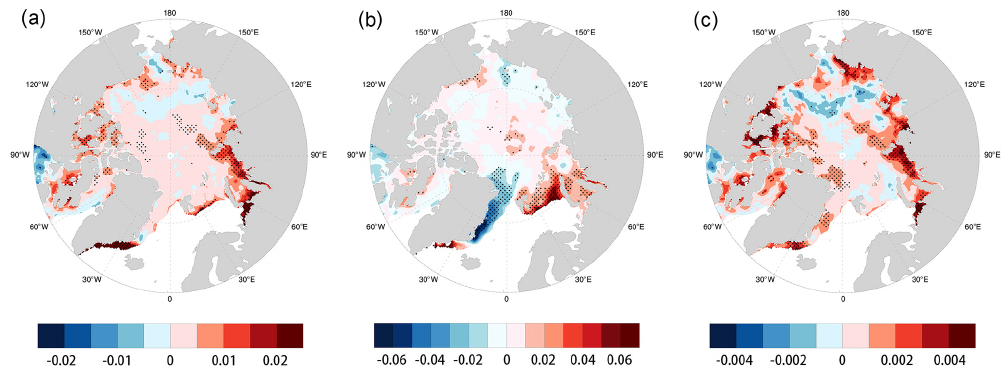
Figure 6. Trend of rainfall (a) , total precipitation (b) , and RPR (c) during March and June based on ERA5 over Arctic sea ice during 1980– 2017. Regions passing a 0.05 significance test are denoted by dots. The trend is derived from the slope of a linear regression. Unit of (a) and (b) : centimeters per decade; unit of (c) : percent per decade.